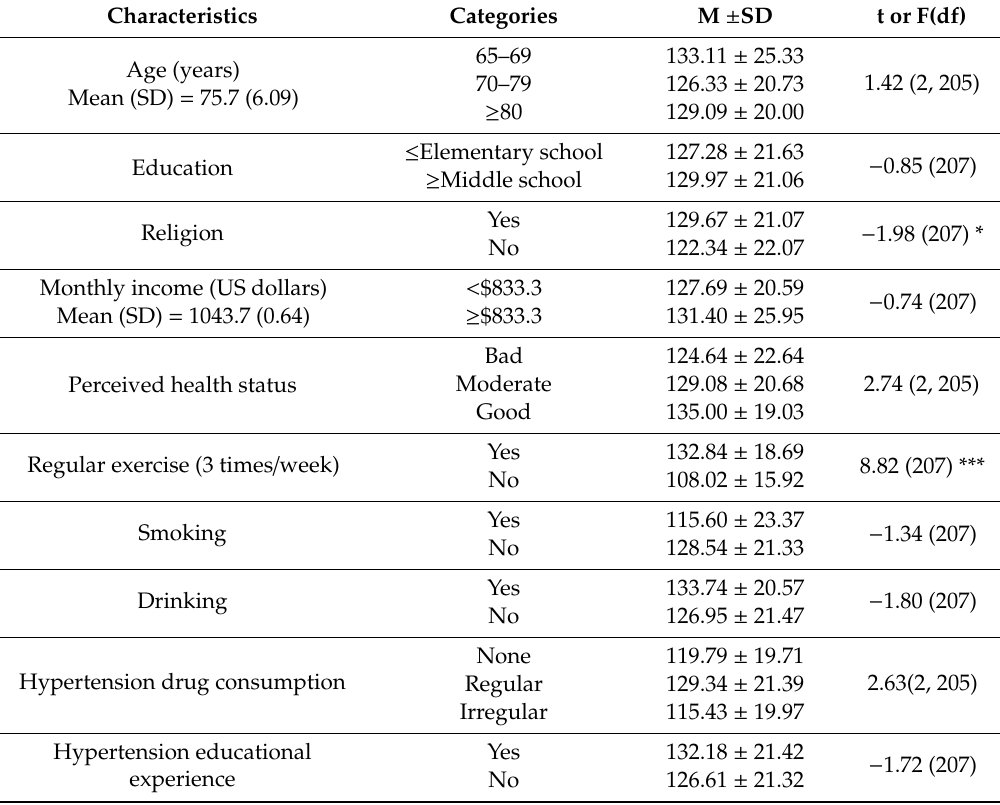
Table 2. Di ff erences in health-promoting behaviors according to sociodemographic.